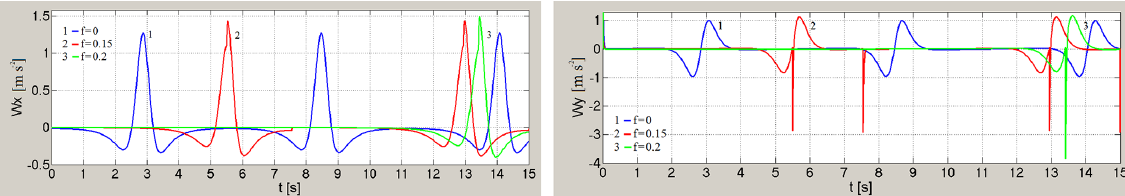
Figure 21. Graphs of acceleration projections Wx ( t ) ∦ Wy ( t ) of point C at different values of the coefficient of sliding friction f and for coefficient of rotational friction k = 0 and for load mass M = 500kg.